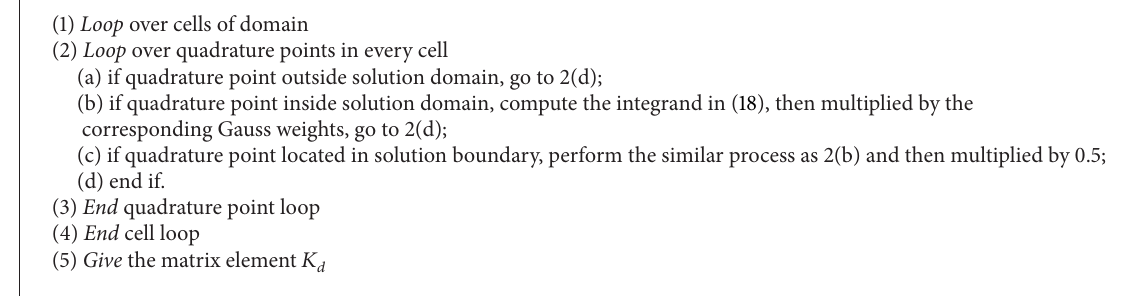
Algorithm 1: Flowchart for background mesh quadrature technique.